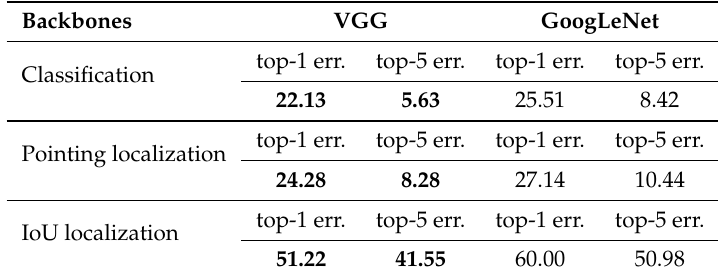
Table 8. Comparison of different backbones on the CUB-200-2011 test set. Backbones VGG GoogLeNet top-1